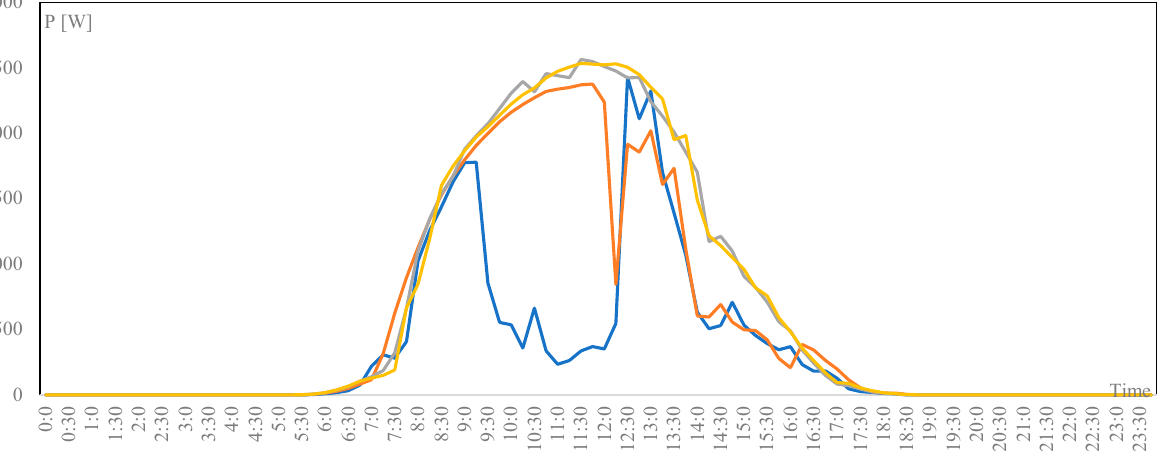
Figure 21. PV power production profiles for the different AEUs: AEU1 (blue), AEU2 (orange), AEU3 (grey), AEU4 (yellow).